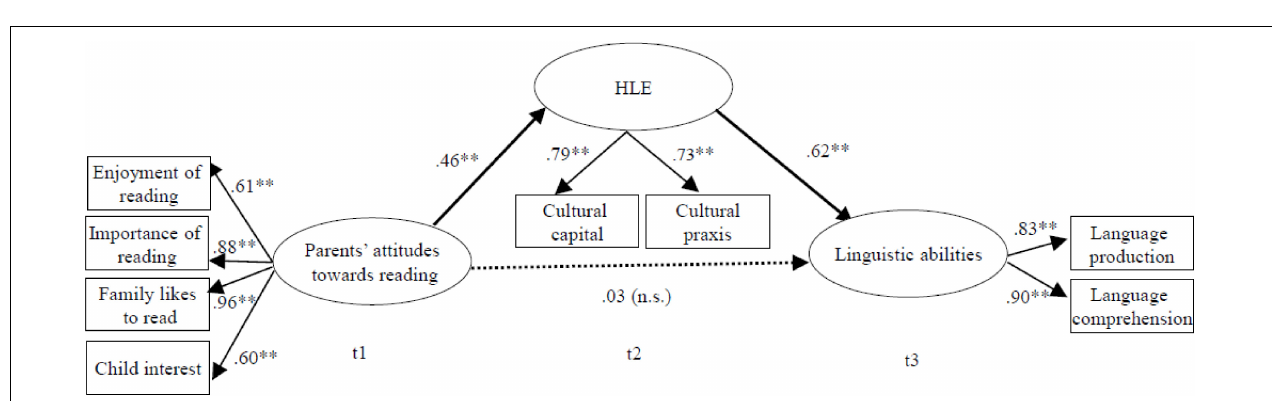
FIGURE 2 | Parental attitudes and their association with children’s linguistic abilities mediated by the home literacy environment. N = 133. Standardized beta coefficients with ** p < 0.01. HLE, home literacy environment. All analyses are controlled for age, sex, intelligence, and parental socioeconomic status (SES) (occupational prestige); root mean square error of approximation (RMSEA) = 0.04, comparative fit index (CFI) = 0.98, Tucker–Lewis Index (TLI) = 0.97, standardized root mean residual (SRMR) =